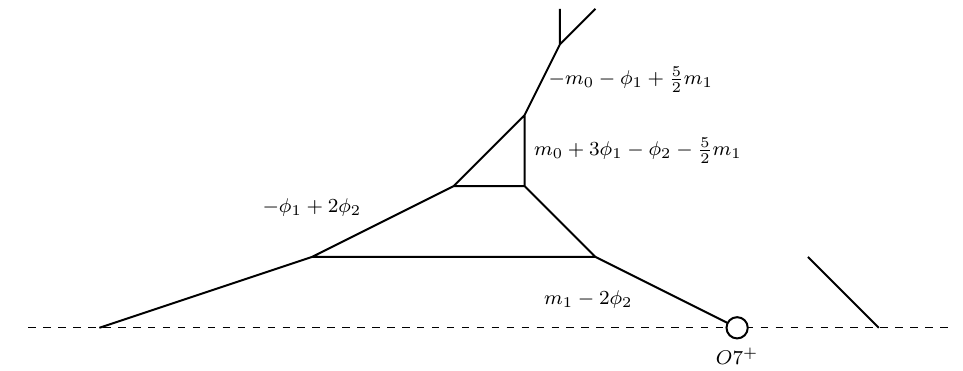
Figure 5. A 5-brane web for SU(3) edge with length φ 1 + m 0 − 5